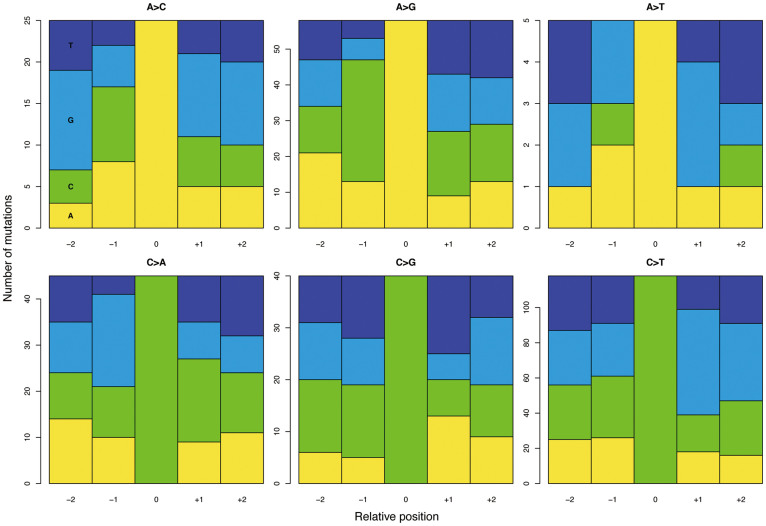
Sequence context of mutated nucleotides. Panels of nucleotide sequence context show proportions of A, C, G, and T within 2 bases before and after mutated bases. The vertical axis indicates the number of nucleotides. See Supplementary Table S2 for exact counts and proportions.